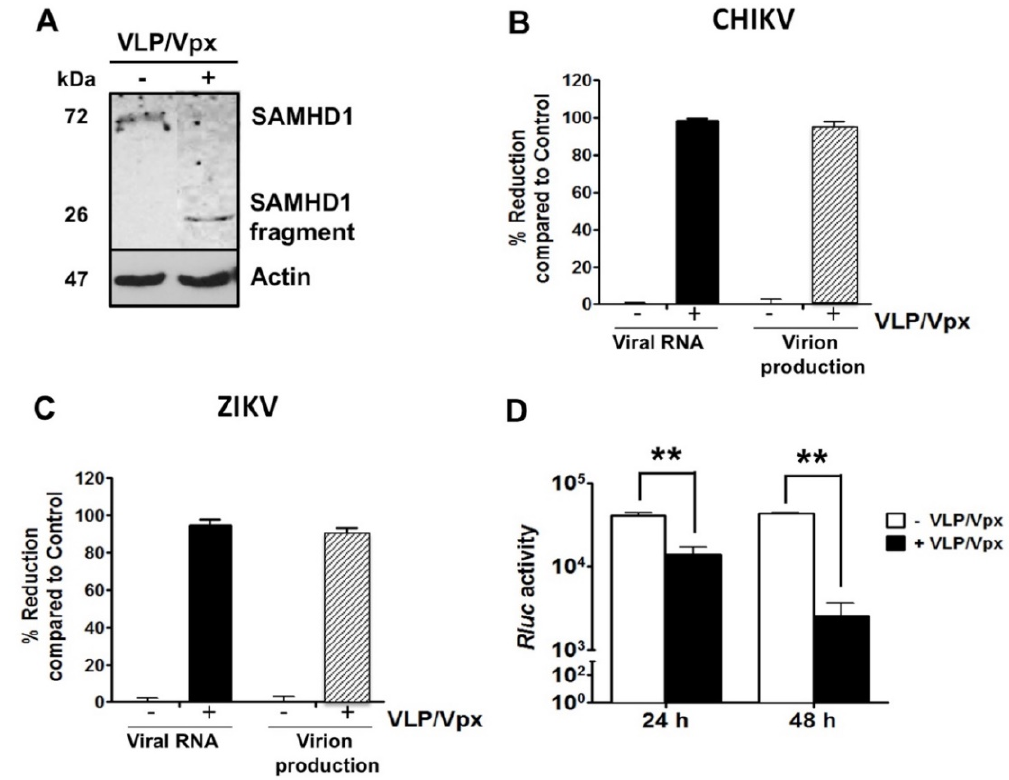
Figure 4. ( A ) Vpx-induced SAMHD1 degradation decreases CHIKV and ZIKV replication. Mock- ( − ) or VLP/Vpx-treated (+) HFF1 cells were infected with CHIKV for 48 h. Infected cells were lysed with TETN-150 and analyzed by immunoblotting using antibodies against SAMHD1 and β -actin. ( B , C ) Vpx-treated and mock-treated HFF1 cells were infected with CHIKV or ZIKV at MOI 1. After 48 h, intracellular viral RNA levels and infectious virus production were measured by real time RT-PCR (black bars) and plaque assay (gray bars), respectively. The percentage of reduction in the presence of Vpx was calculated using the formula [1 − (R/C)] × 100, where C and R designate experimental values (RNA copy numbers or plaque numbers) as a function of Mock- or VLP/Vpx-treated cells, respectively. ( D ) Stable Huh-7 cells harboring the CHIKV-NCT replicon were untreated or treated with VLP/Vpx. Twenty-four and 48 h post-treatment, cells were lysed and Renilla Luciferase ( Rluc ) activity was measured. Relative Rluc activity expressed by the CHIKV replicon represents the magnitude of CHIKV RNA replication. Values are normalized according to protein content of the cell extract and correspond to the mean of triplicates ± SD. The data represent the mean values ± SD from three independent experiments. ** p -value < 0.01, as compared to untreated cells.